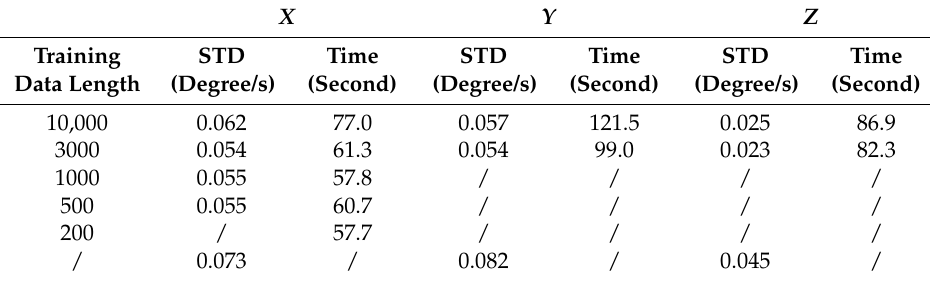
Table 3. Training results of the three-axis